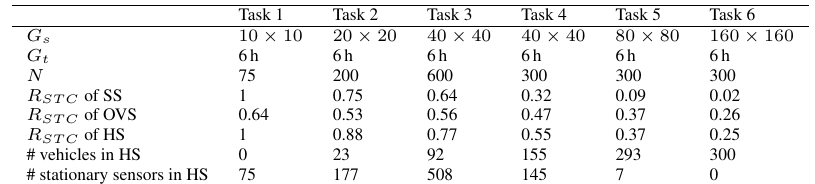
Table 2. Six tasks and the ratio of spatio-temporal coverage in stationary, opportunistic vehicular and hybrid sensing.